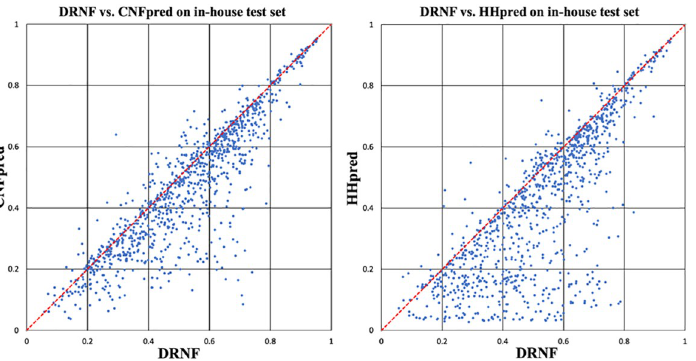
Fig 2. The TMscore of the 3D models built from the alignments generated by DRNF, CNFpred and HHpred on our in-house test set. (left) DRNF vs. CNFpred; (right) DRNF vs. HHpred. Each point represents two alignments generated by two competing methods for the same protein